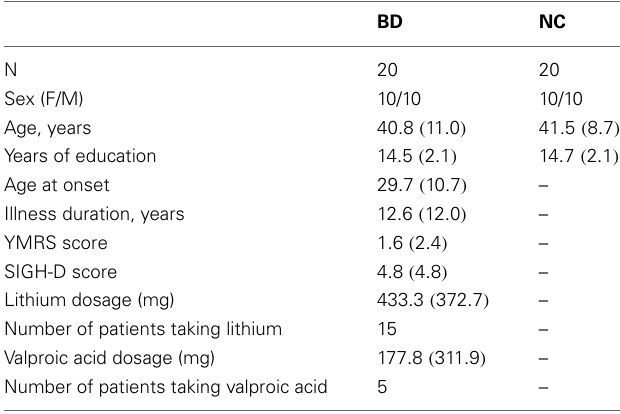
Table 1 | Participants’ demography, clinical measurements, and medication status information.